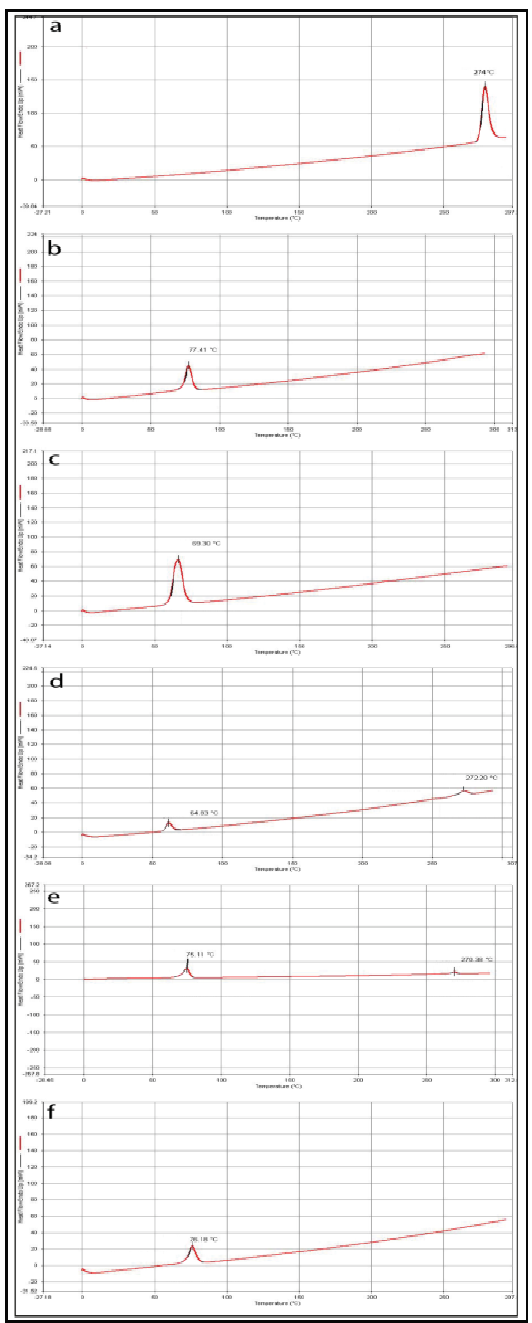
Figure 11: Differential Scanning Calorimetry Thermograms of TP (a), GB (b), SA (c), TP – NPs (d), TP – GB Physical Mixture (e) and F O